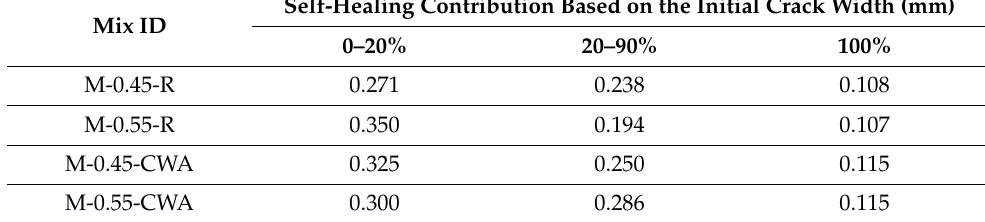
Table 5. Relationship between the self-healing contribution and initial crack width.